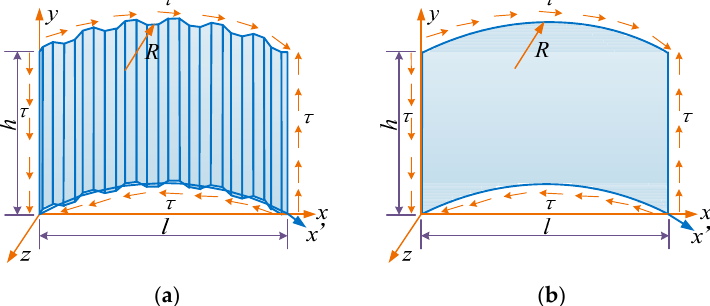
Figure 2. Corrugated steel web and its equivalent orthotropic cylindrical shallow shell: ( a ) Corrugated steel web; ( b ) Equivalent orthotropic cylindrical shallow shell.